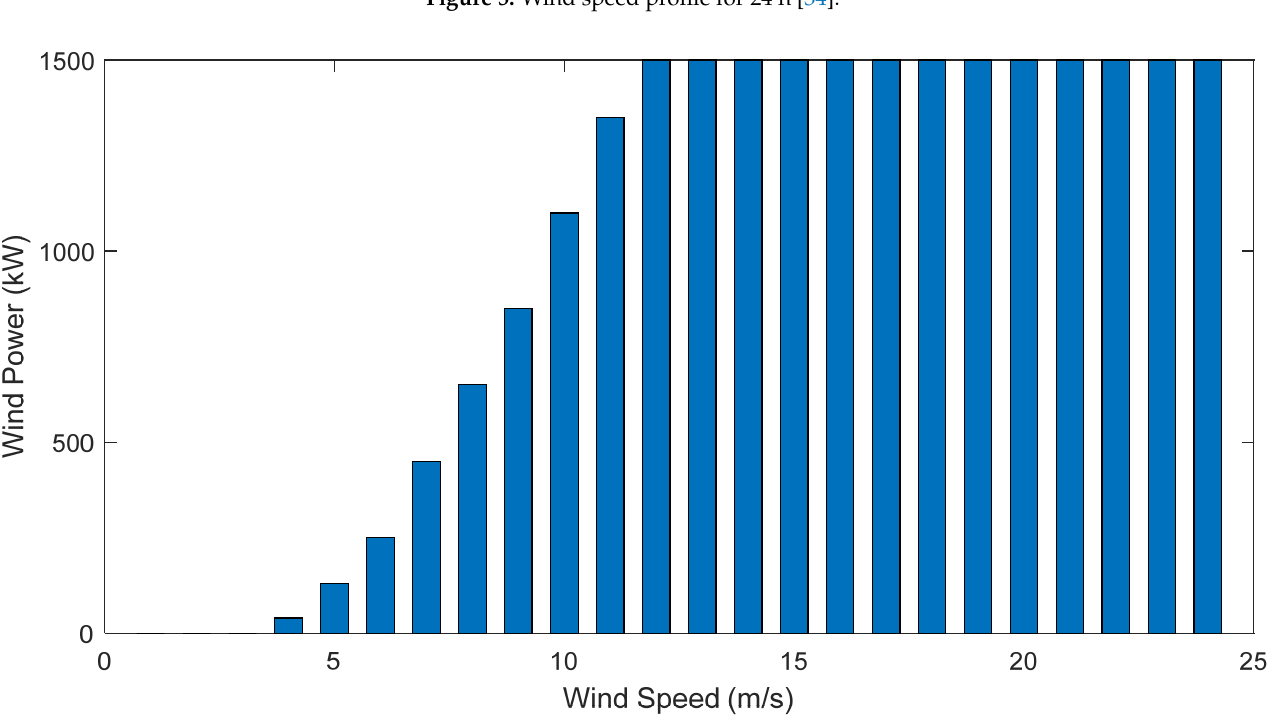
Figure 5. Wind speed profile for 24 h [34].